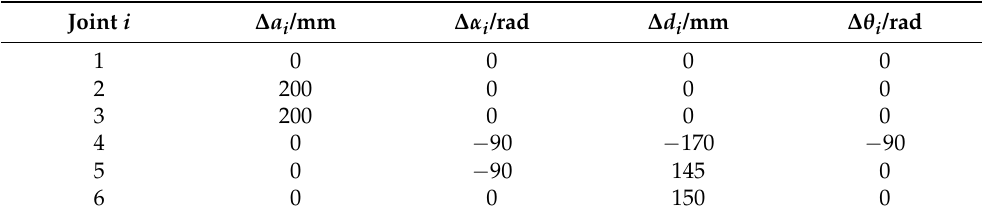
Table 1. Theoretical parameters of